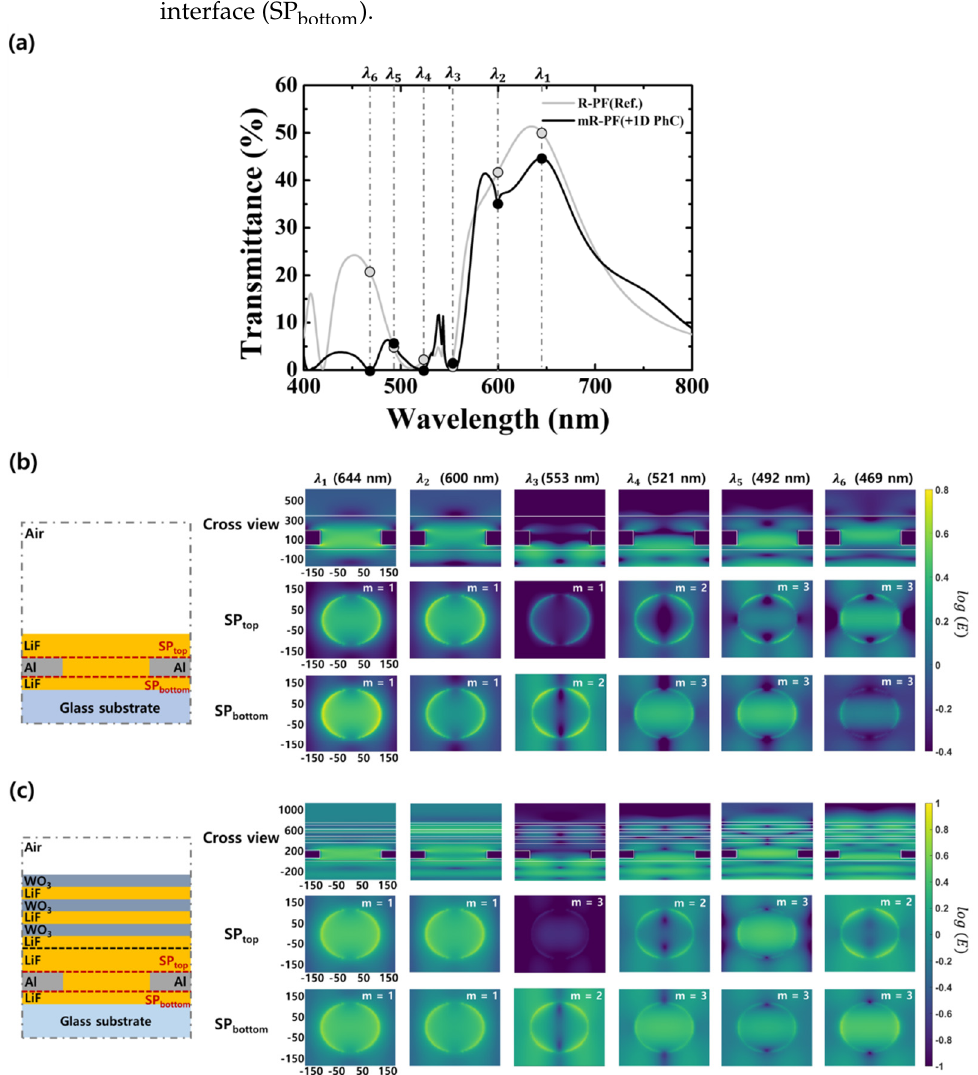
Figure 4. Spectral response and profile images of the electric field of the R-PF and mR-PF. ( a ) Transmission spectra of the R-PF and mR-PF at inflection points [ (cid:2019) (cid:2869) (644 nm), (cid:2019) (cid:2870) (600 nm), (cid:2019) (cid:2871) (553 nm), (cid:2019) (cid:2872) (521 nm), (cid:2019) (cid:2873) (492 nm), and (cid:2019) (cid:2874) (469 nm)]. Schematic of the simulation structures and electric field profile images for ( b ) the R-PF and ( c ) mR-PF at the inflection points.